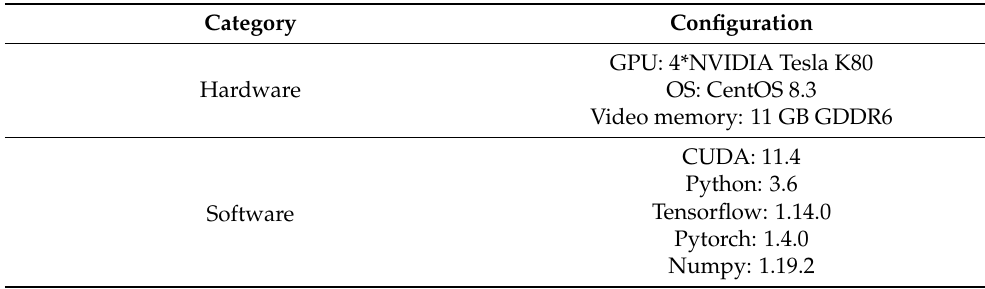
Table 2. Experimental environment. CUDA is a parallel computing platform and programming model invented by NVIDIA, headquartered in Santa Clara, California, USA. Python is a programming